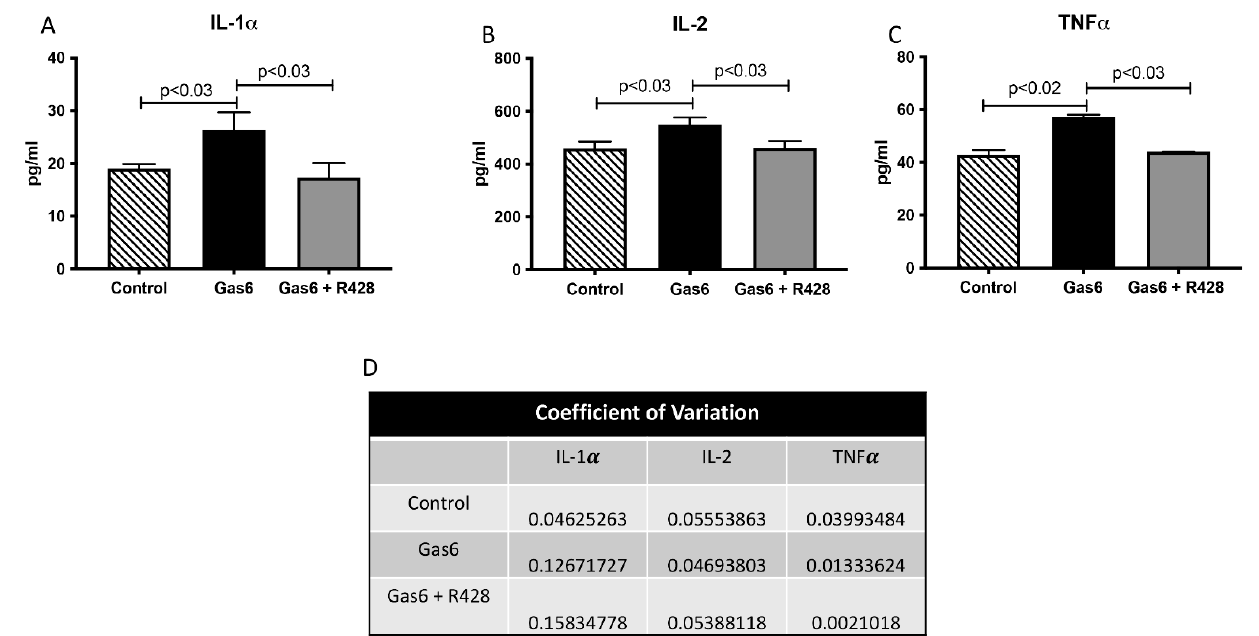
Figure 5. Inflammatory cytokines in the serum of control and treated animals. Serum levels of IL- 1 𝜶 ( A ), IL-2 ( B ), and TNF 𝜶 ( C ) were increased in Gas6-treated animals compared to controls (n = 10). Cytokines were deceased in animals co-treated with R428. Coefficients of variations for the ex- periments are found in ( D ). Representative data are shown with p ≤ 0.05.